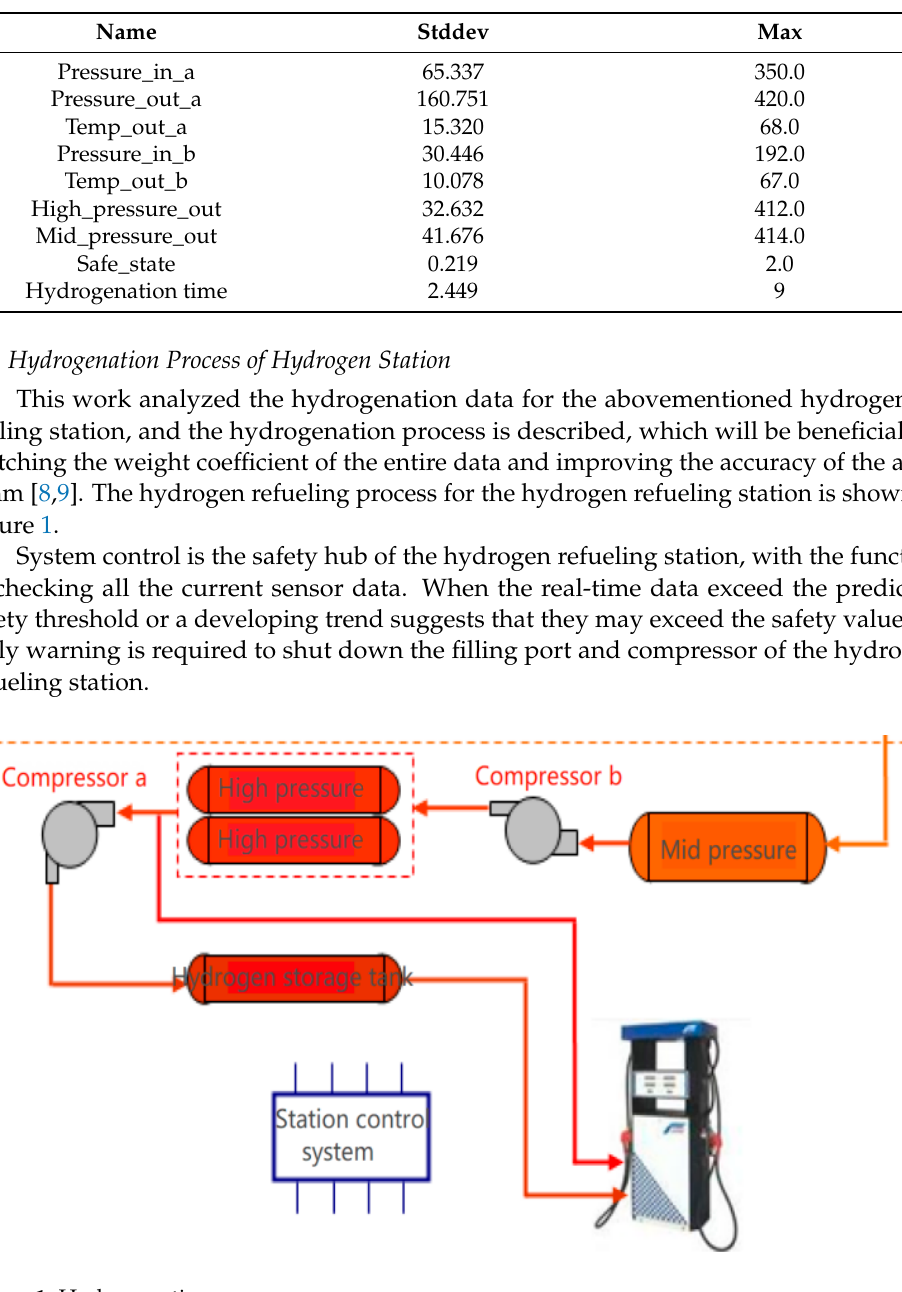
Table 1. Hydrogen data description.